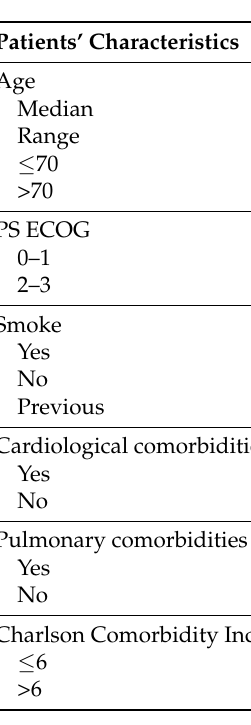
Table 1. Patients’ characteristics ( n =